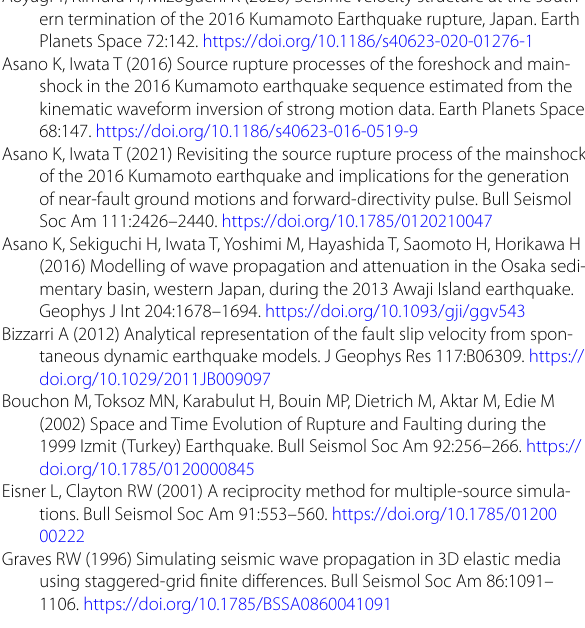
{7.2, 7.2, 10}, lg Mo 0 =